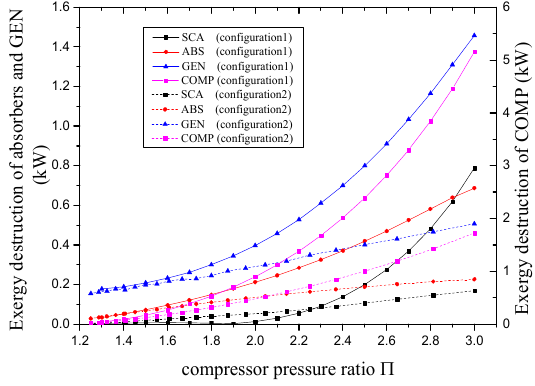
π at T = 100 ◦ C. GEN